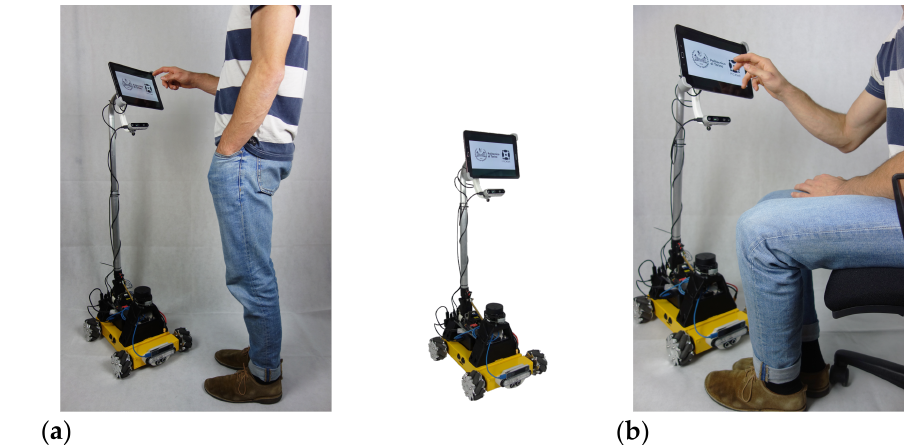
Figure 5. Final prototype of the mobile assistive robot in two different working configurations: ( a ) Deployed configuration for standing usage, HMI height = 1.1 m, mechanism tilting angle = 0°, ( b ) Retracted end angled configuration for better-seated usage, HMI height = 0.80 m, mechanism tilting angle =